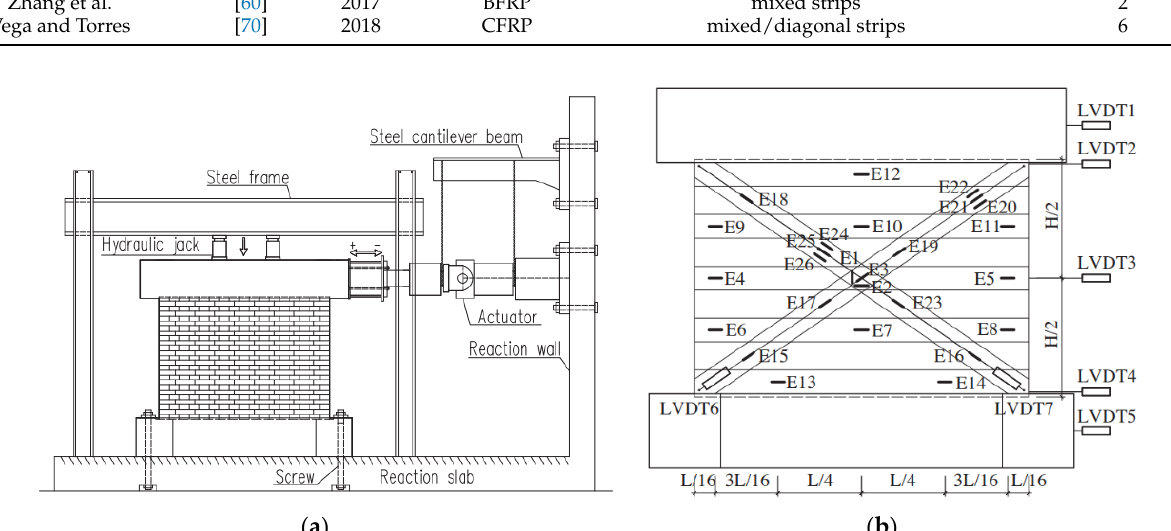
Figure 7. BFRP reinforcement URM walls tests [31]: ( a ) Test setup, ( b ) Instrumentation of the wall specimens. Reproduced with permission from Zhou, D.; Lei, Z.; Wang, J. In ‐ plane behavior of seismically damaged masonry walls repaired with external BFRP; published by Elsevier, Composite Structures, 2013. Table 1. General information on the experimental FRP ‐ reinforced masonry samples included in the database .